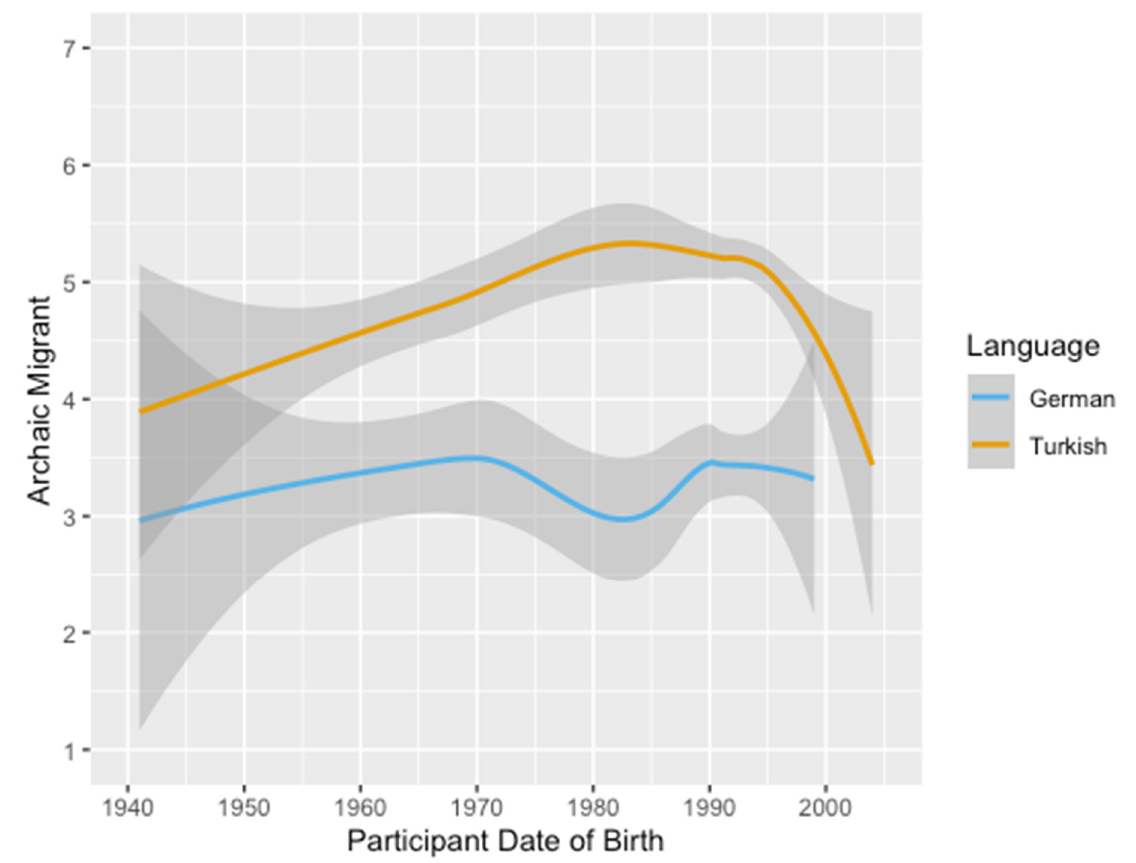
Figure 2. Smoothed conditional means of the “archaic migrant” variable plotted against the “participant date of birth” variable, grouped by language. The grey area shows 95% confidence intervals. Likert scale: 1 = do not agree at all, 7 = completely agree. Figure created using the ggplot2 package in R (Wickham 2016).